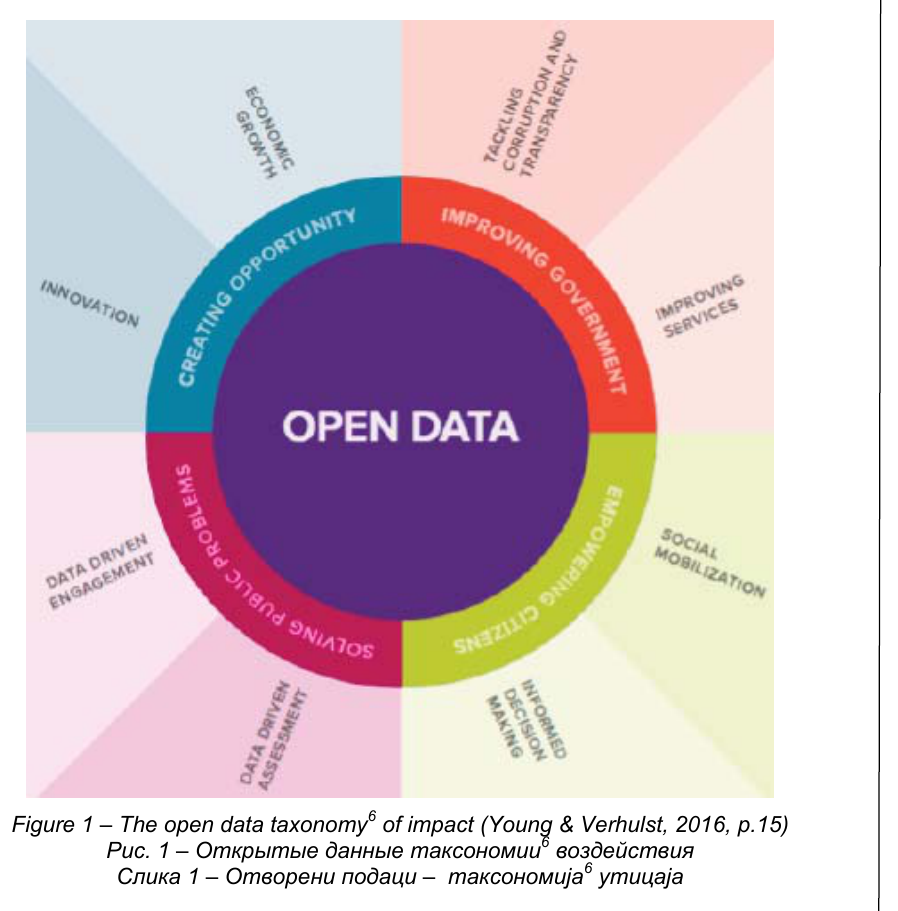
Figure 1 – The open data taxonomy 6 of impact (Young & Verhulst, 2016,